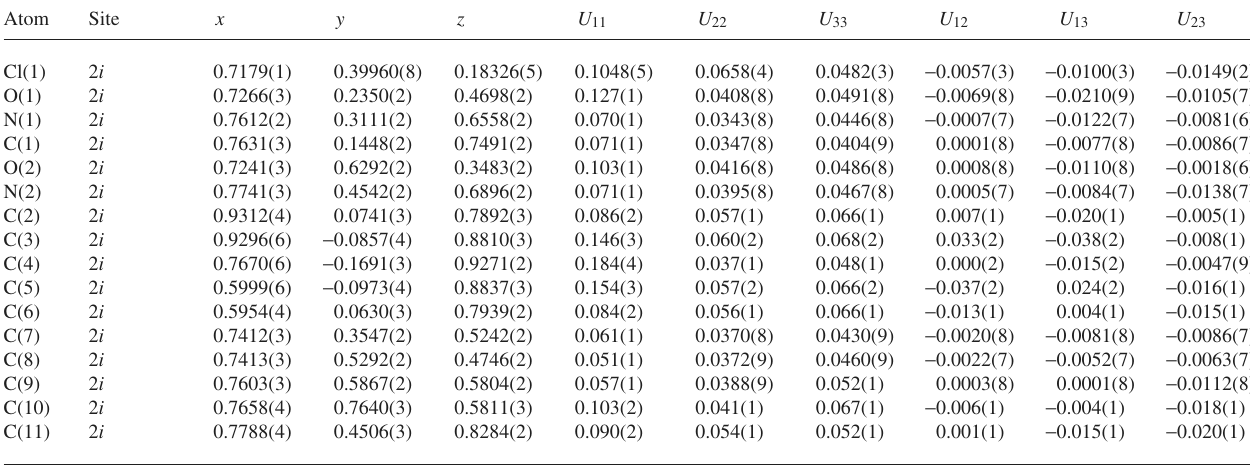
Table 3. Atomic coordinates and displacement parameters (in Å 2 ) .